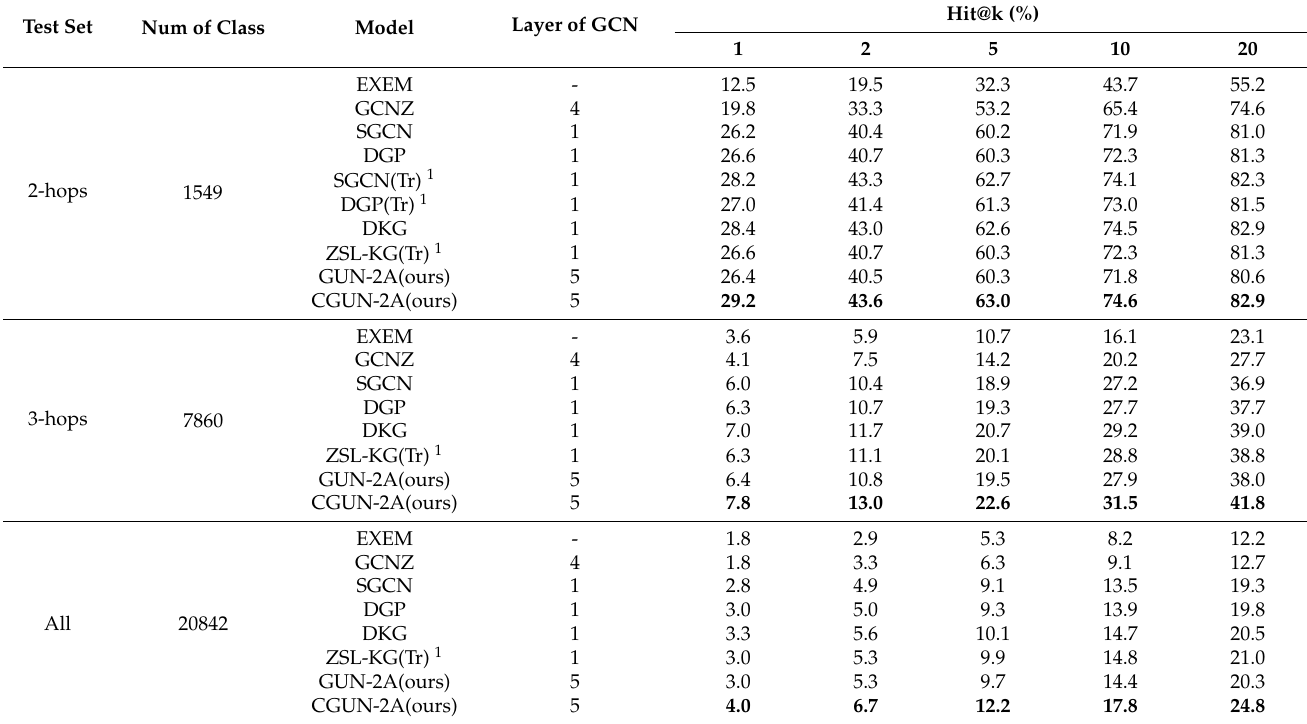
Table 1. Hit@k performance for different methods on three datasets. Only testing on the un- seen